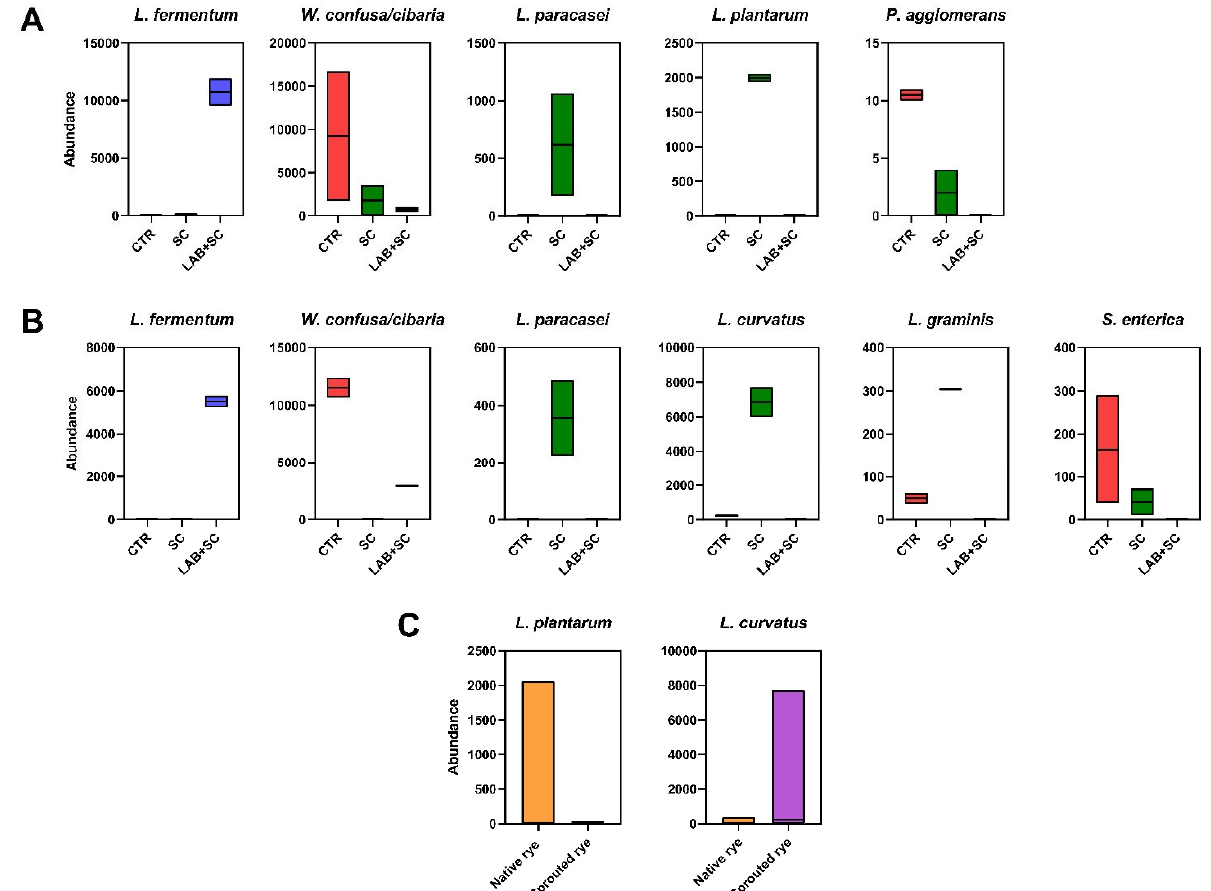
Figure 3. Differential abundance analysis of bacterial species among rye doughs. Box and whiskers plot indicate the proportion of differentially abundant taxa between starters used for fermentation in native rye doughs ( A ) and in sprouted rye doughs ( B ), and between native and sprouted rye doughs ( C ). Only significant species (FDR < 0.05) detected by DESeq2 are reported in the figure. Boxes represent the minimum and maximum of abundance values of replicates for each condition; the line in the box is the median.